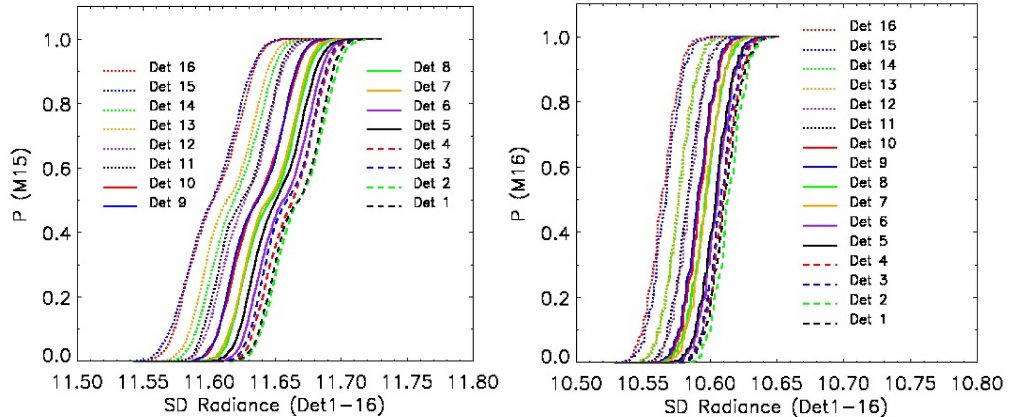
` ˘ m 2 ¨ Sr ¨ µ m ) over the Bay of Bengal in